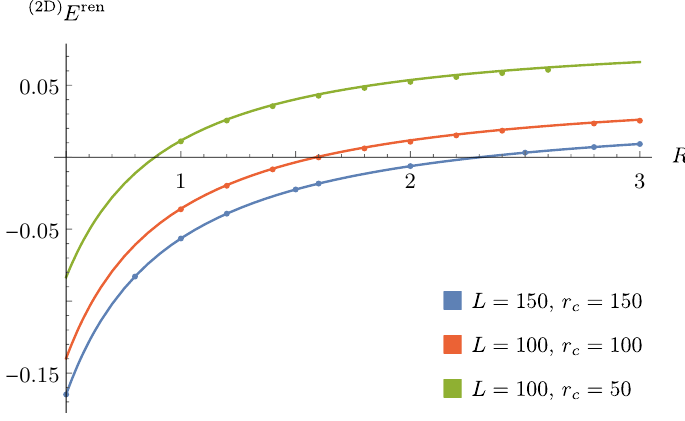
Figure 7 . Casimir energy, calculated numerically (data points) for a = 0 . 1 and three different sets of parameters r c and L . We fitted the analytical approximation − π with free coefficients c i , to the numerical result for r c = 150 and L = 150 (blue data points). The resulting function, with such determined coefficients c 1 ’ 0 . 50 , c 2 ’ 0 . 48 , c 3 ’ 0 . 37 and c 4 ’ 0 . 51 , is plotted for r c = 150 (blue curve), r c = 100 (red curve) and r c = 50 (green